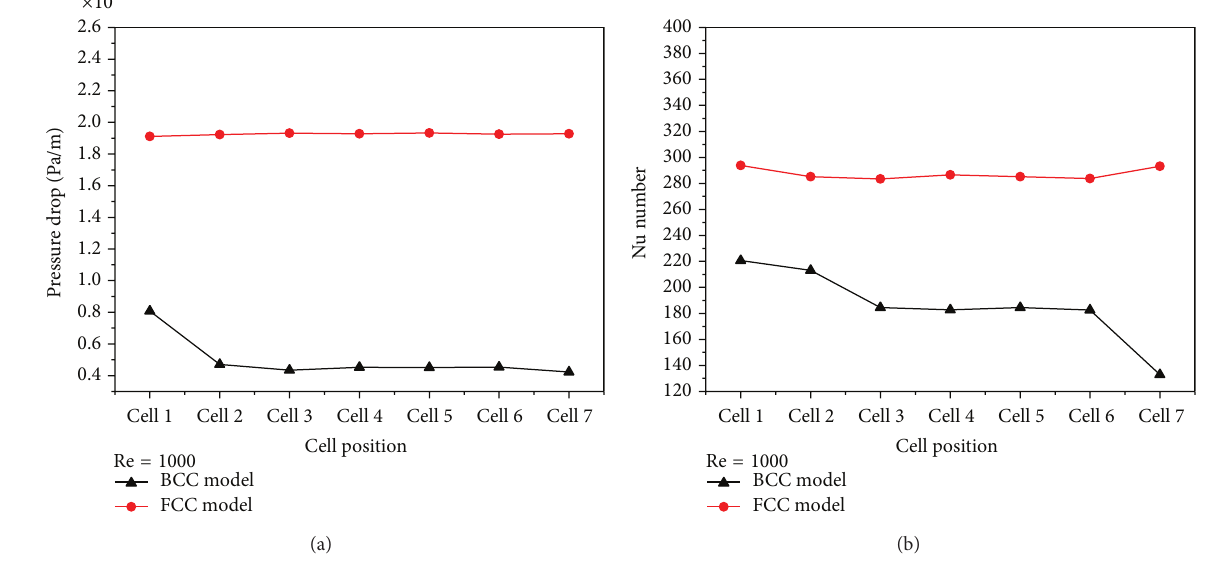
Figure 3: Pressure drop and Nu number of BCC and FCC